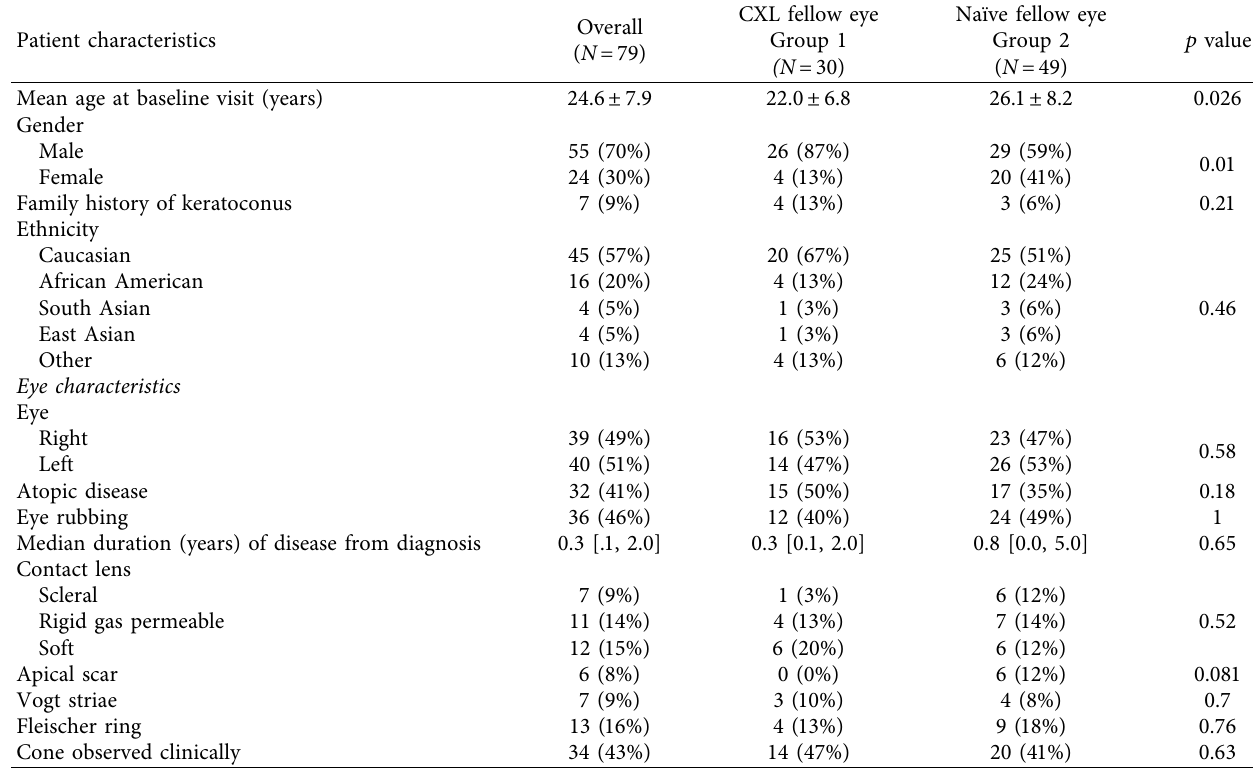
Table 1: Patient Characteristics of crosslinked and na¨ıve fellow